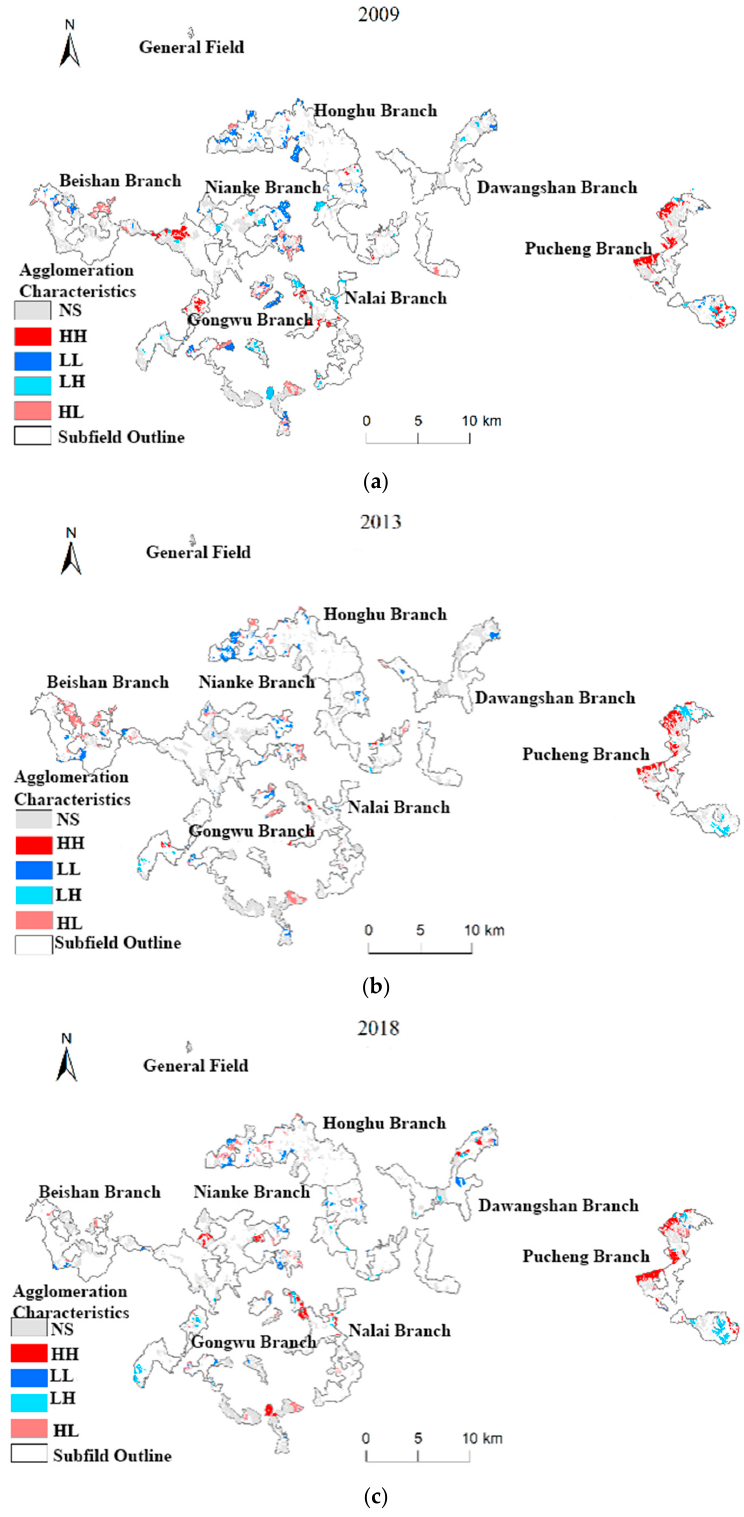
Figure 6. These Local LISA plots show the relationship between wood supply and soil conservation services in PM plantations in Paiyangshan Forest Farm from 2009 to 2018. The plots are categorized into NS (not significantly clustered), HH (high–high clustering), LL (low–low agglomeration), LH (low–high agglomeration), and HL (high–low agglomeration). The LISA maps for wood supply and soil conservation services are presented for three years: ( a ) 2009, ( b ) 2013, and ( c )